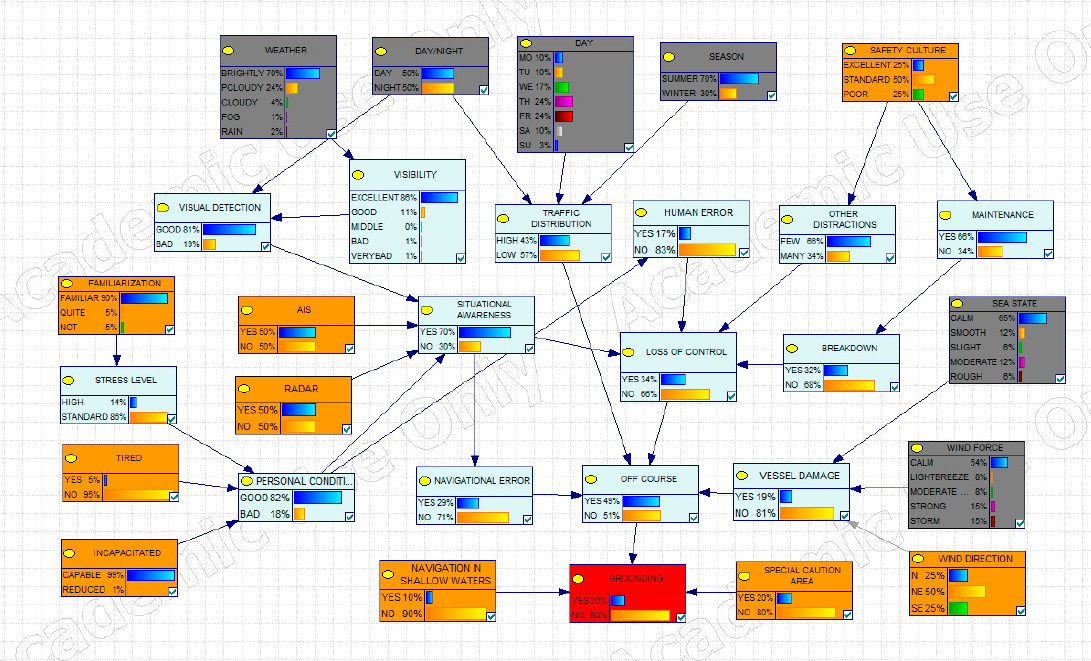
Figure 4. Quantitative grounding model for passenger non-liner small vessels.